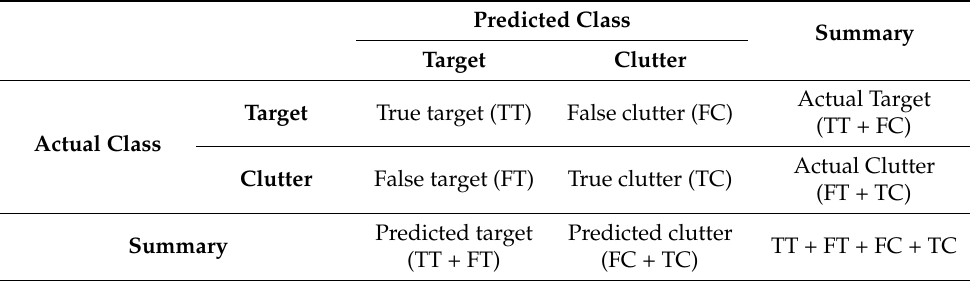
Table 3. Confusion matrix of sea-surface weak target